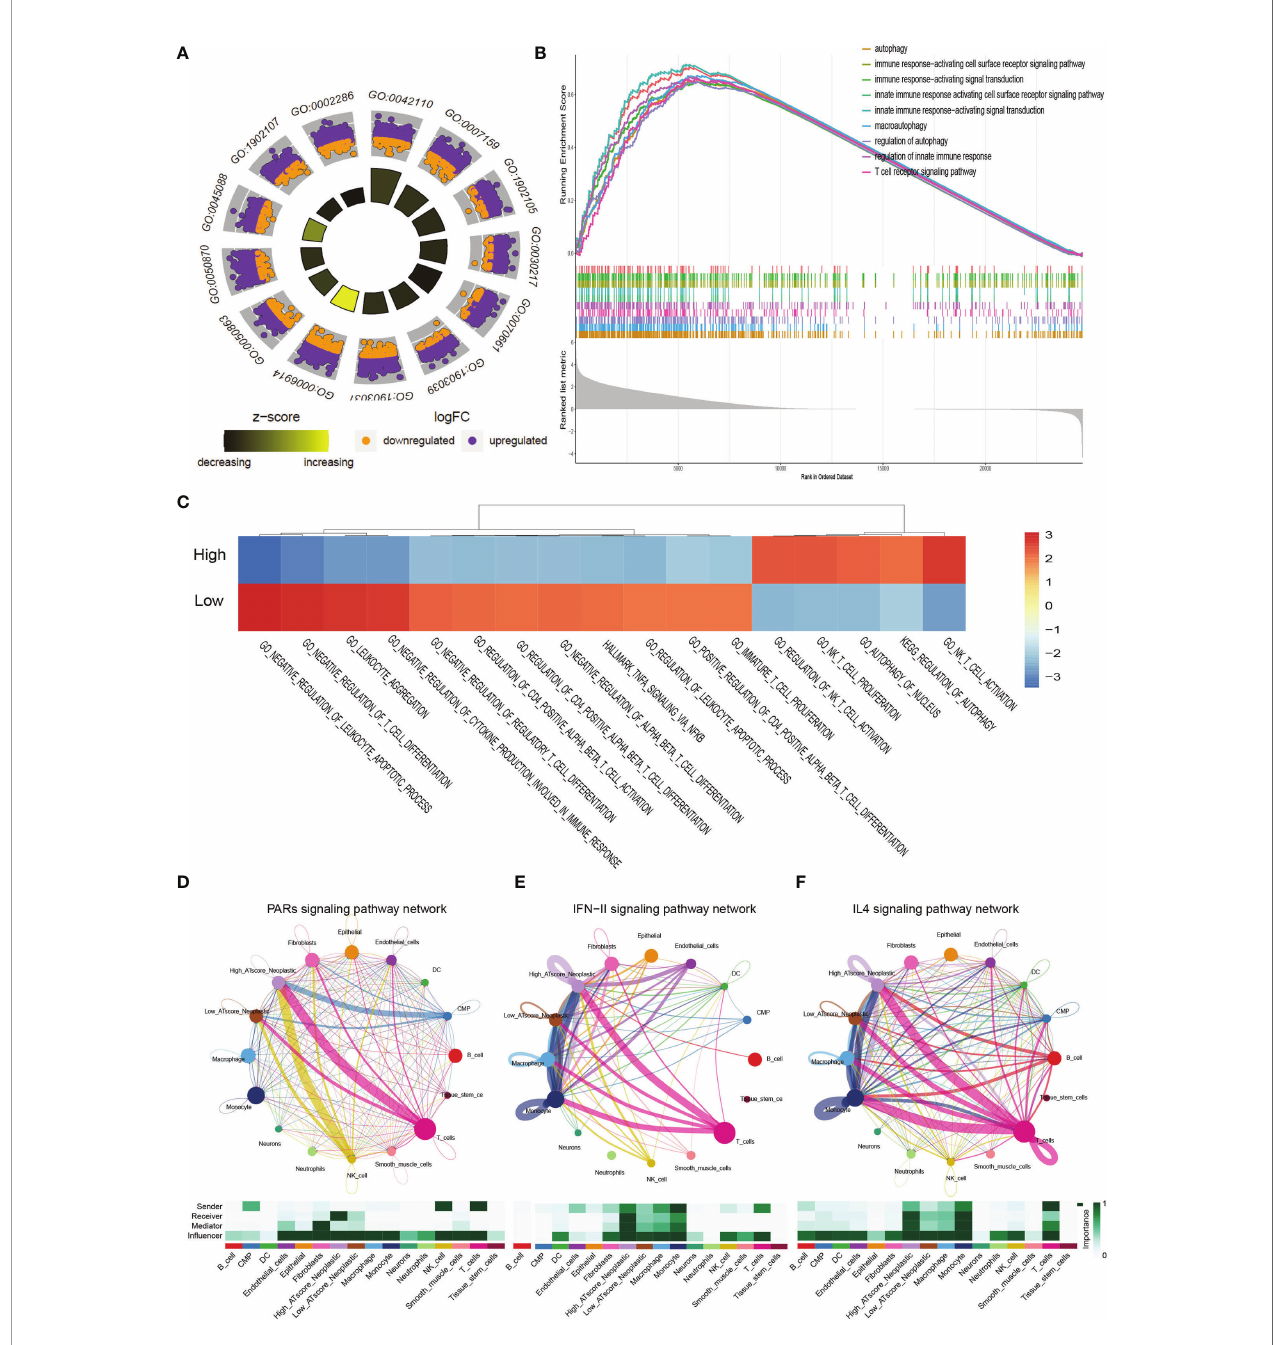
FIGURE 7 | The correlation of ATscores with immune cells in fi ltrating and the cellular communication patterns. GO enrichment analysis (A) , GSEA (B) and GSVA (C) revealed that two ATscore groups had different autophagy and immune response-related cellular functions and signaling pathways. The cells with various ATscore levels have diverse tumor-related (PARs signaling) and immune response-related signaling pathway (IFN-II signaling and IL4 signaling) patterns (D – F) . Tumor cells with different ATscore levels play different roles in cellular interactions with tumor microenvironment